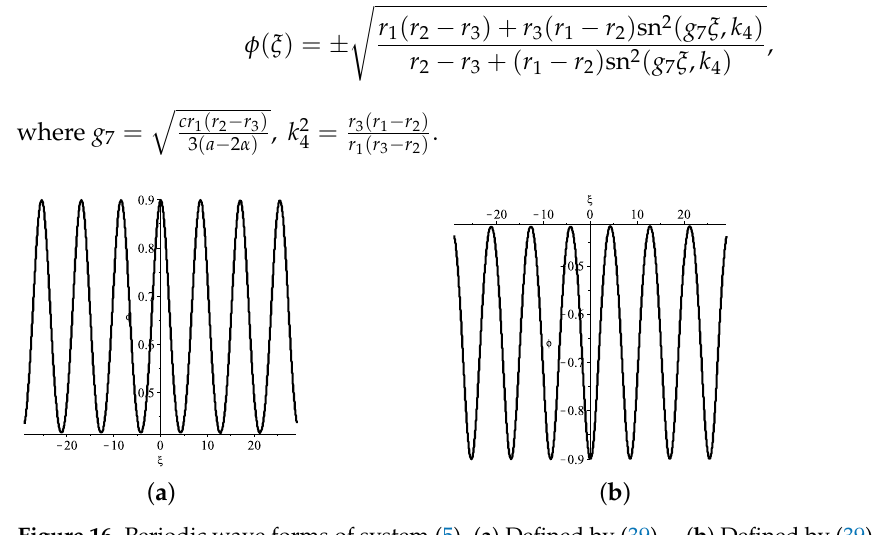
Figure 16. Periodic wave forms of system (5). ( a ) Defined by (39) + . ( b ) Defined by (39) −